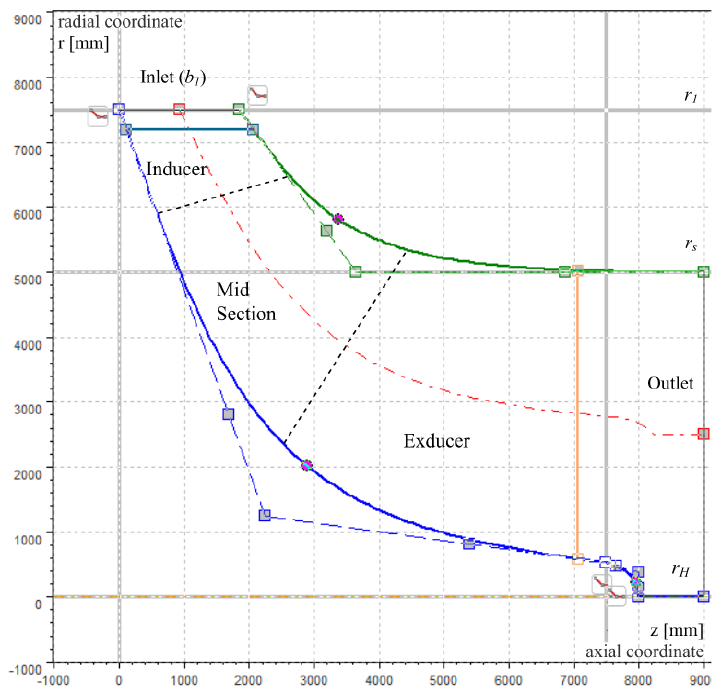
Figure 5. Main geometrical features of the radial inflow (RIF) blade.